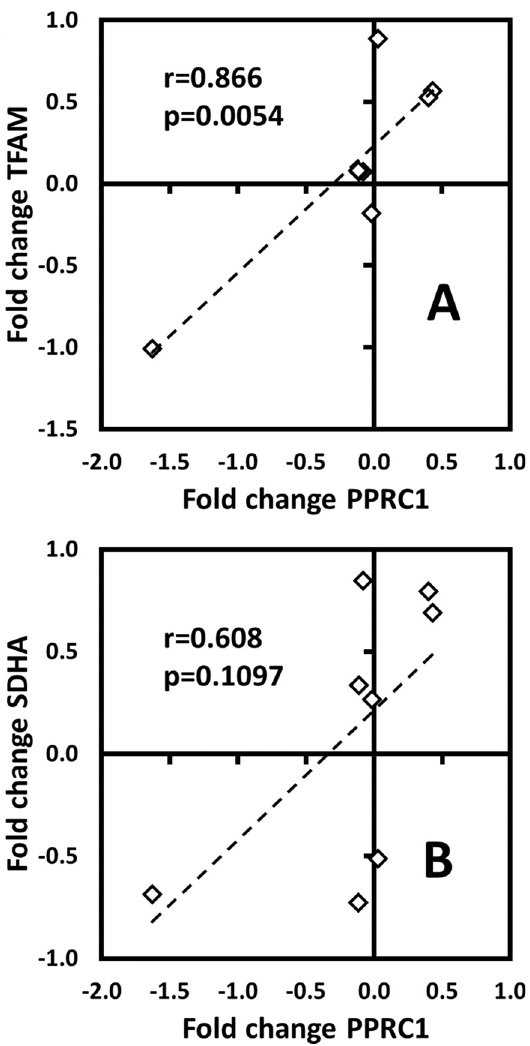
Figure 4 - Pearson’s correlation analysis of gene expression of PPRC1 vs. TFAM and PPRC1 vs. SDHA in 8 cell lines. The gene expressions from cell lines FDH98, FDH111, FDH113, XPHM16VI, XPHF16VI, XP17VI, XP4PAandAS860wereplottedinascatterX&YchartandPearson’scor- relation(r value )wascalculated.A)Pearson’scorrelationofgeneexpression between PPRC1 ( x -axis) vs. TFAM ( y -axis). B) Pearson’s correlation of gene expression between PPRC1 ( x -axis) vs. SDHA ( y -axis). Control cell lines MRC-5 and FDH107 were excluded from the analysis owing to its biased reference values.